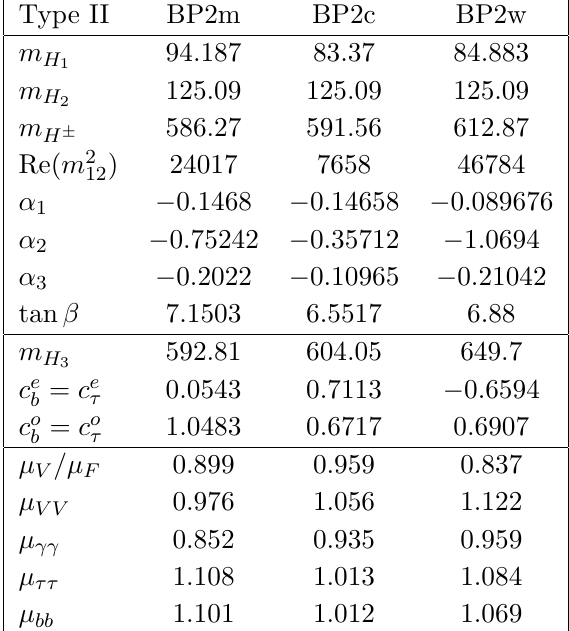
Table 3 . Benchmark points with large pseudoscalar Yukawa couplings in Type II, h 1-8 contain the input parameters; lines 9-11 the derived third Higgs boson mass and the relevant Yukawa couplings (multiplied by sgn( c ( h